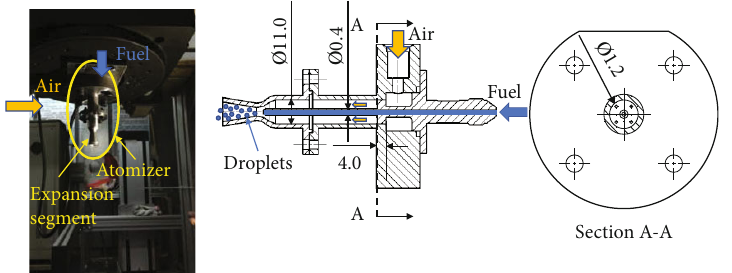
Figure 1: The cross segment of investigated plain-jet airblast